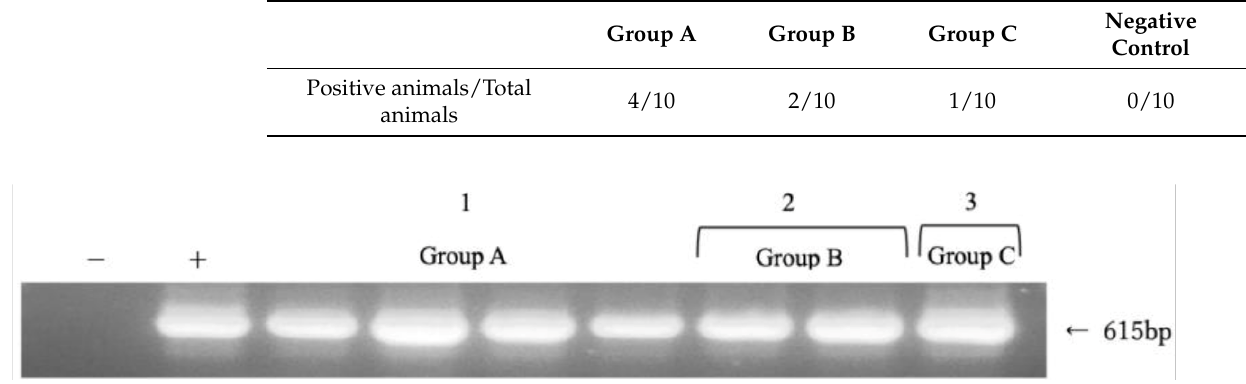
Figure 4. Positive results of multiplex PCR for blood cultures. The 615 bp band specifically identifies Candida albicans among Candida spp. Lane − : negative control (buffer), lane +: positive control ( C. albicans ).